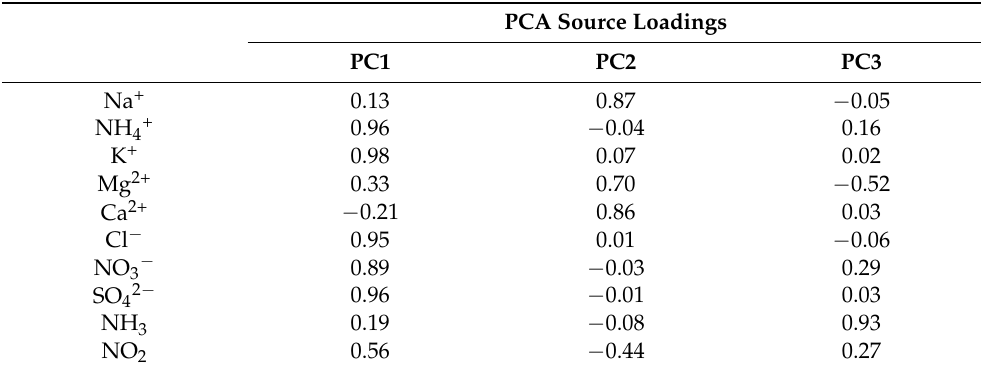
Table 4. Results of principal component